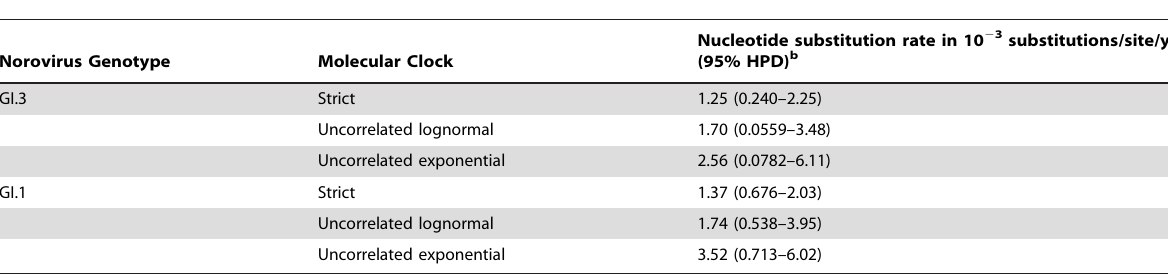
Table 2. Nucleotide Substitution Rates for the VP1 Gene of GI.3 and GI.1 Noroviruses a .